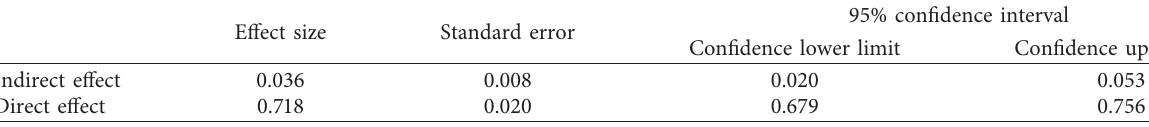
Table 4: Bootstrap test of mediation effect.